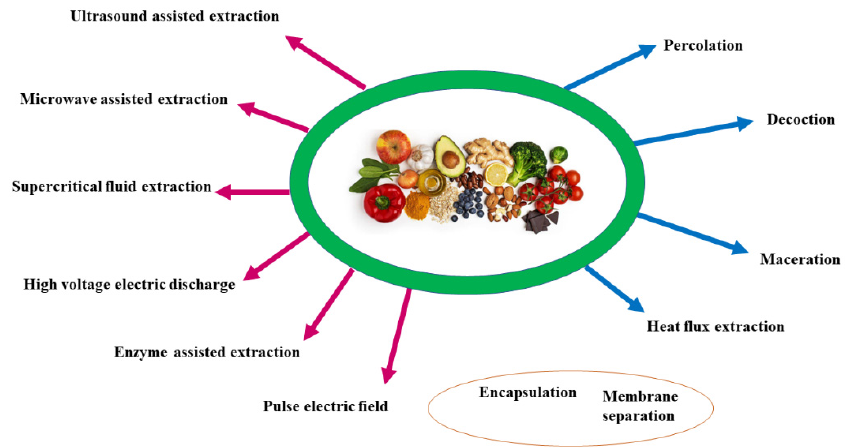
Figure 4. The polyphenols’ traditional and modern extraction methods. Blue arrows: traditional extraction methods; red arrows: modern methods; in the orange circle: techniques used to improve polyphenol management.